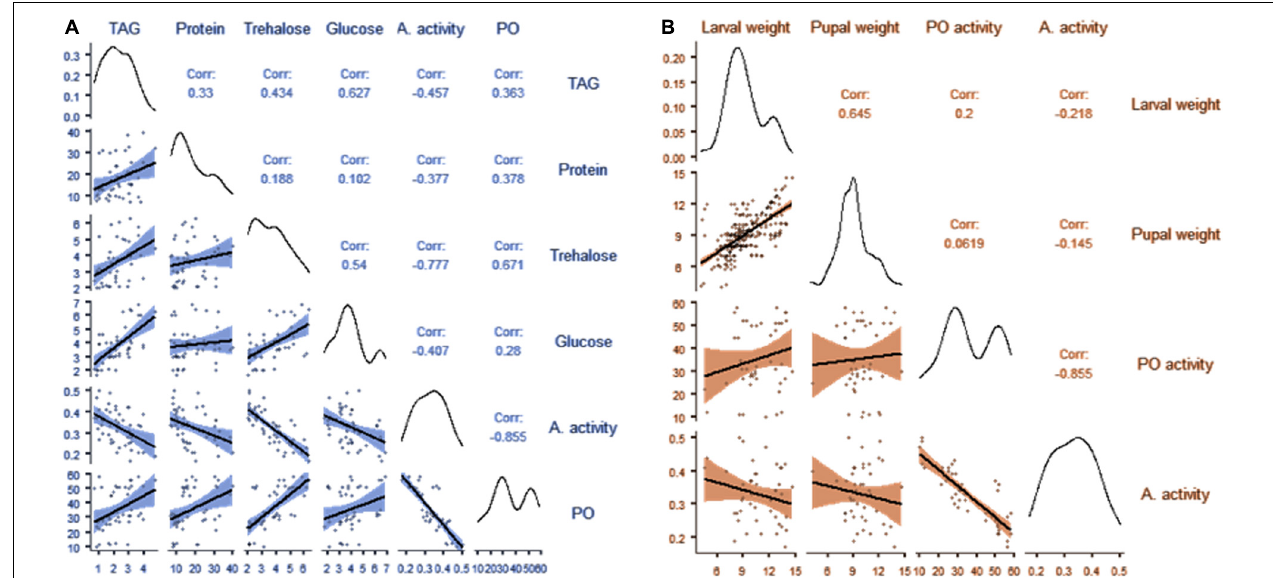
FIGURE 5 | Correlation matrix showing the relationships between the nutritional indices and immunity of B. dorsalis larvae (A) ; correlation matrix showing the relationships between the weight of larvae, the weight of pupae and immunity in B. dorsalis larvae (B) .